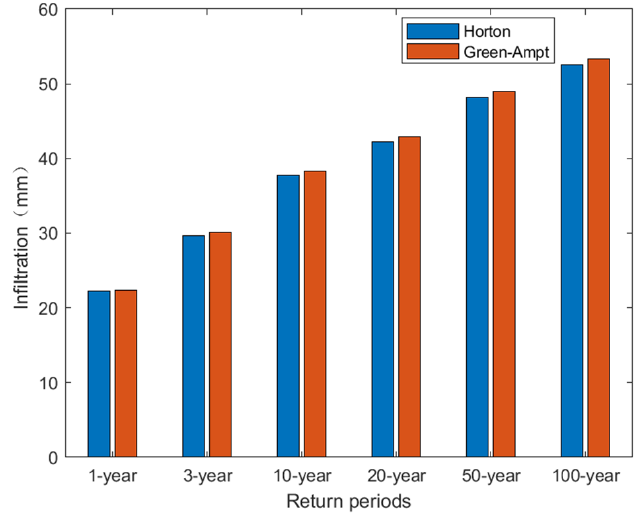
Figure 9. The infiltration depths of the LID scenario simulated by the two infiltration methods.